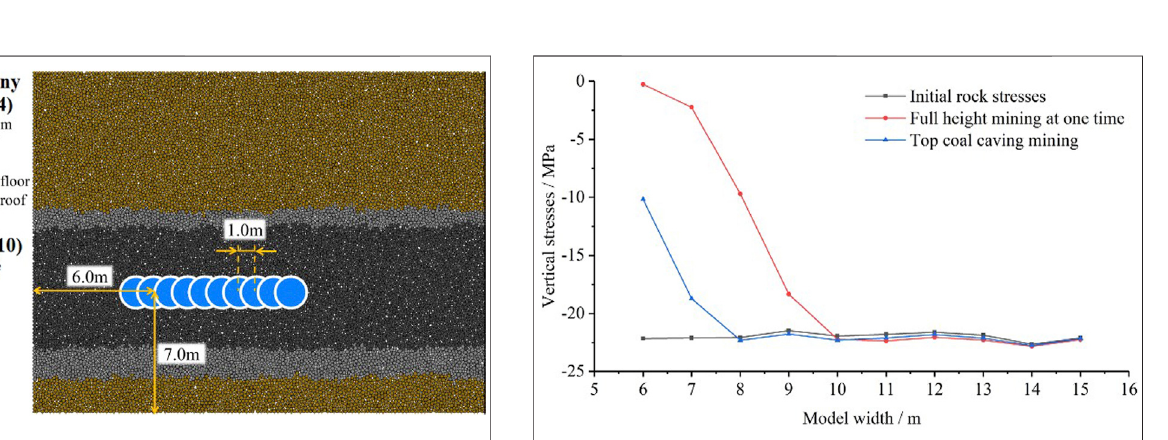
FIGURE8| Fracture propagation law oftwomining methods. (A) Numerical simulation results ofthetopcoal cavingmining. (B) Numerical simulation results ofthe full height mining at one time.